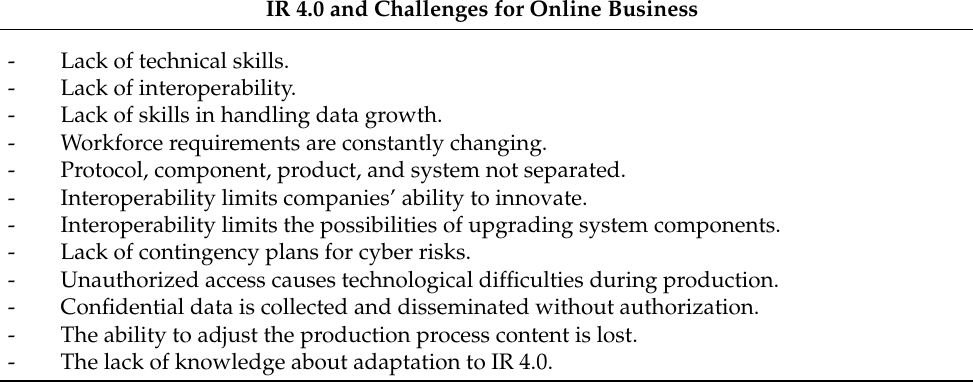
Table 2. Challenges to online business in the IR 4.0